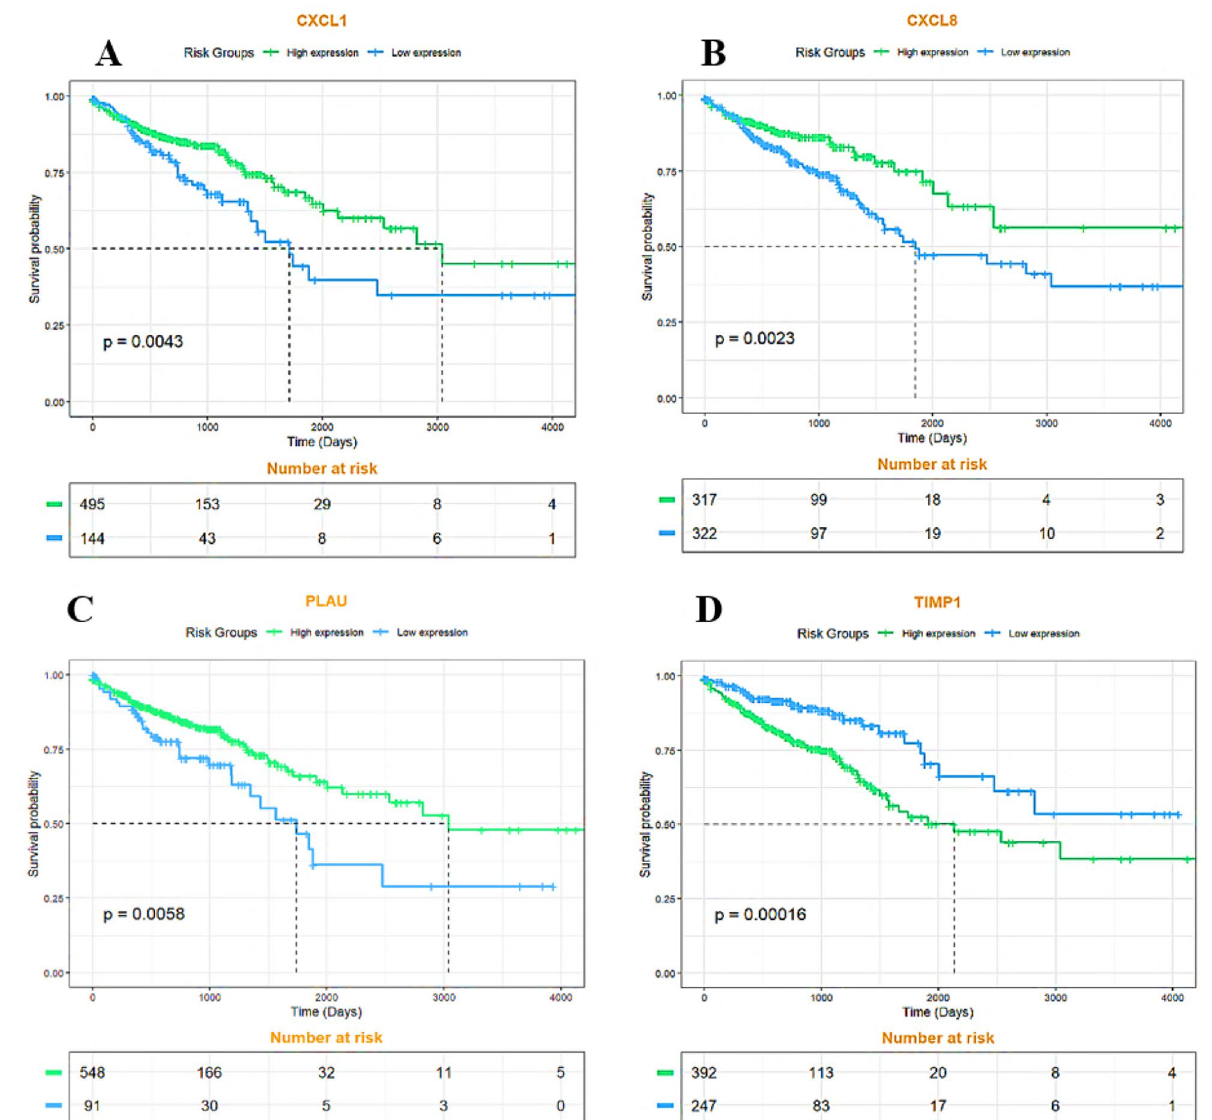
Figure 12. Kaplan–Meier plot of survival analysis of central genes. Survival analysis for the four mentioned hub genes was significant p value < 0.05. ( A ) CXCL1 gene ( B ) CXCL8 gene ( C ) PLAU gene ( D ) TIMP